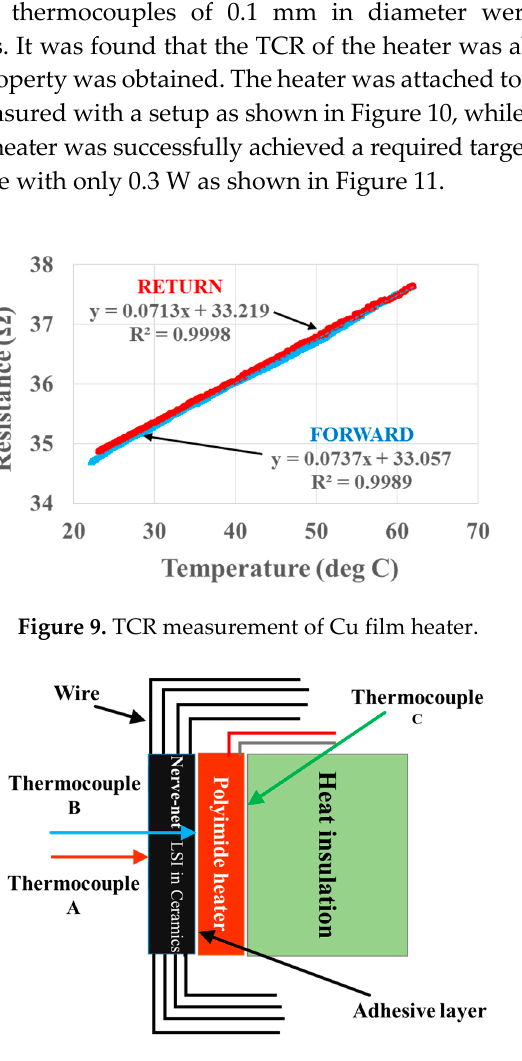
Figure 10. Heating up and down experimental